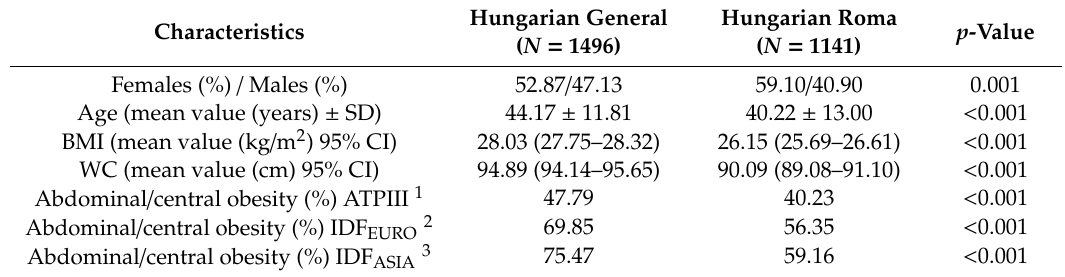
Table 1. Demographic and anthropometric characteristics of Hungarian general and Roma populations.